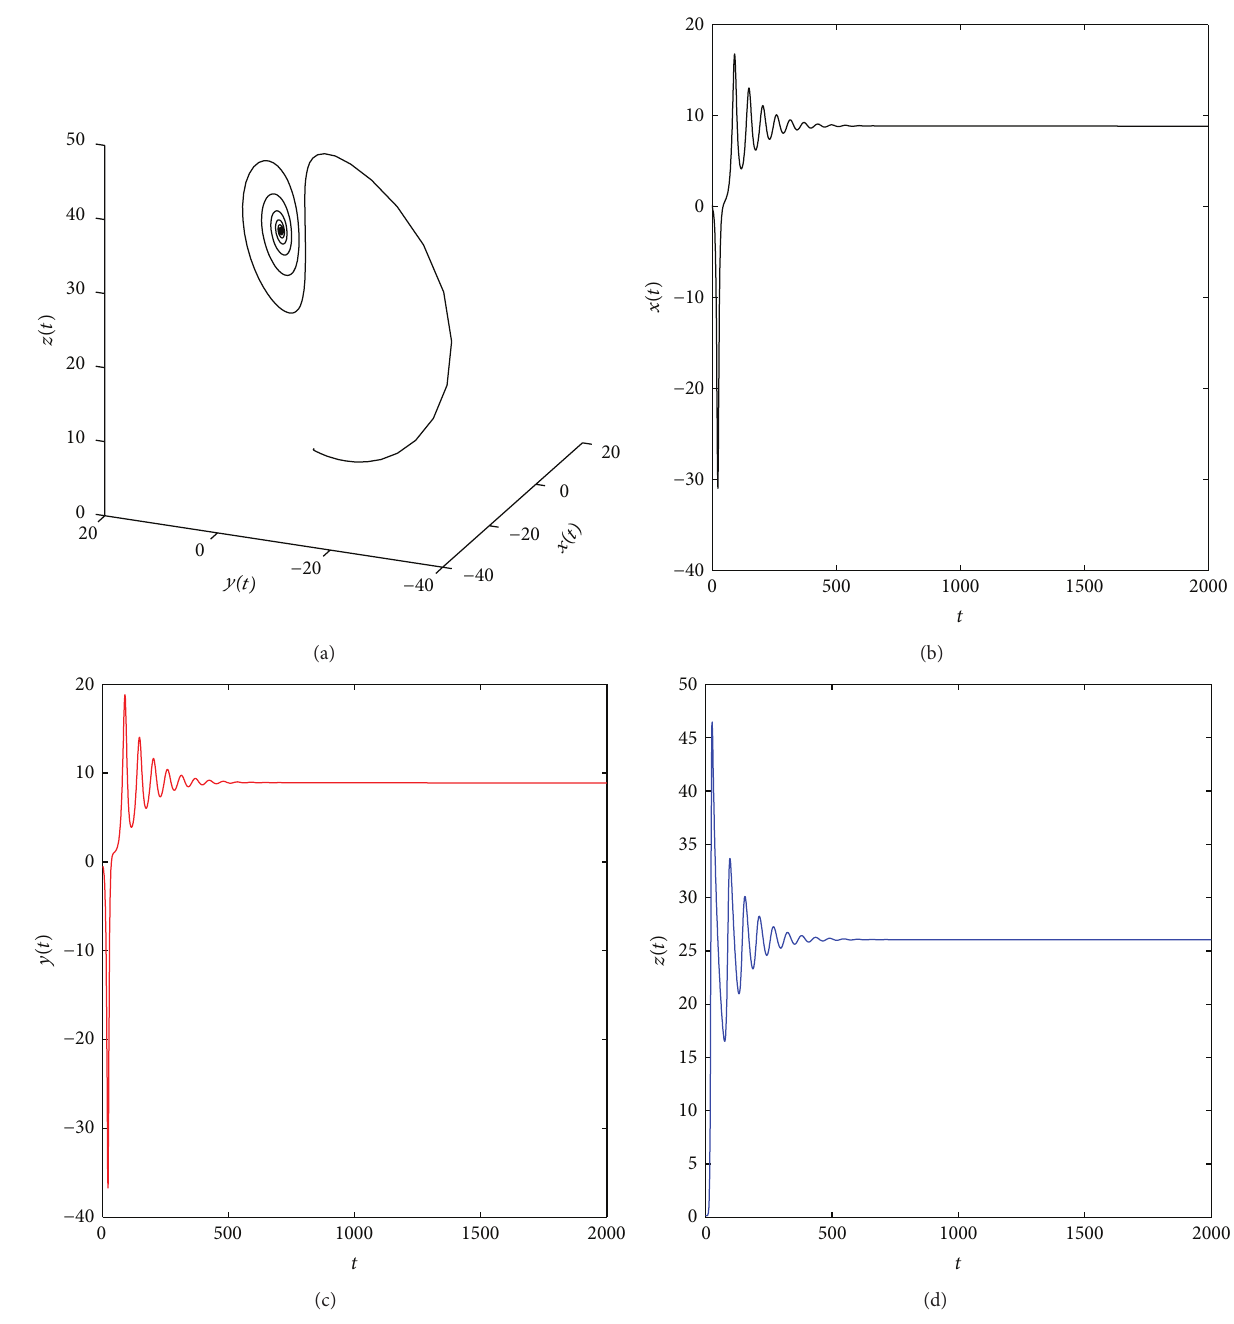
Figure 3: The equilibrium point ̂𝑥 2 of the distributed order fractional Chen system (22) with ( 𝑞 1 ,𝑞 2 , 𝑞 3 ) = (0.7, 0.8, 0.9) and (𝑎,𝑏, 𝑐) = (30, 3,28) is asymptotically